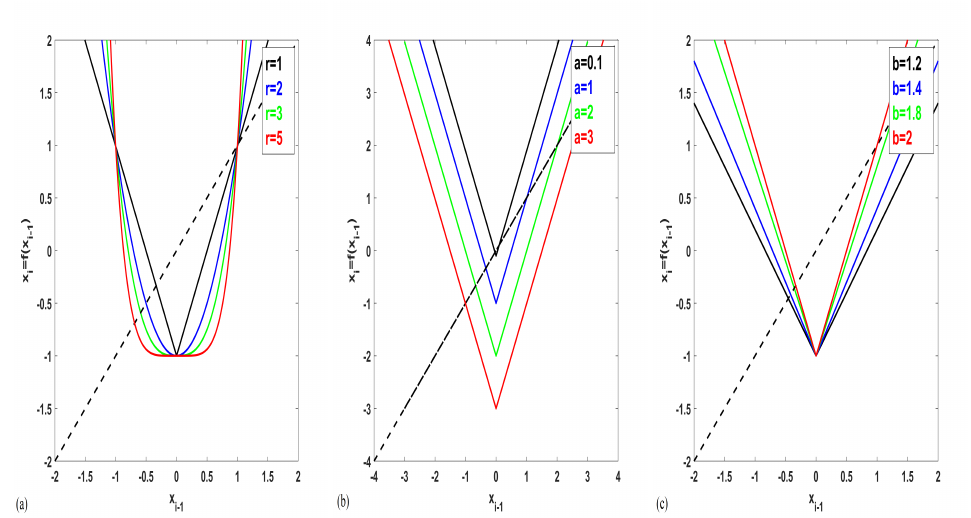
Figure 1. Phase portrait depicting x i as a function of x i − 1 for different values of: ( a ) r , for a = 1, b = 1.99; ( b ) a , for b = 1.99, r = 1; ( c ) b , for a = 1 and r = 1.